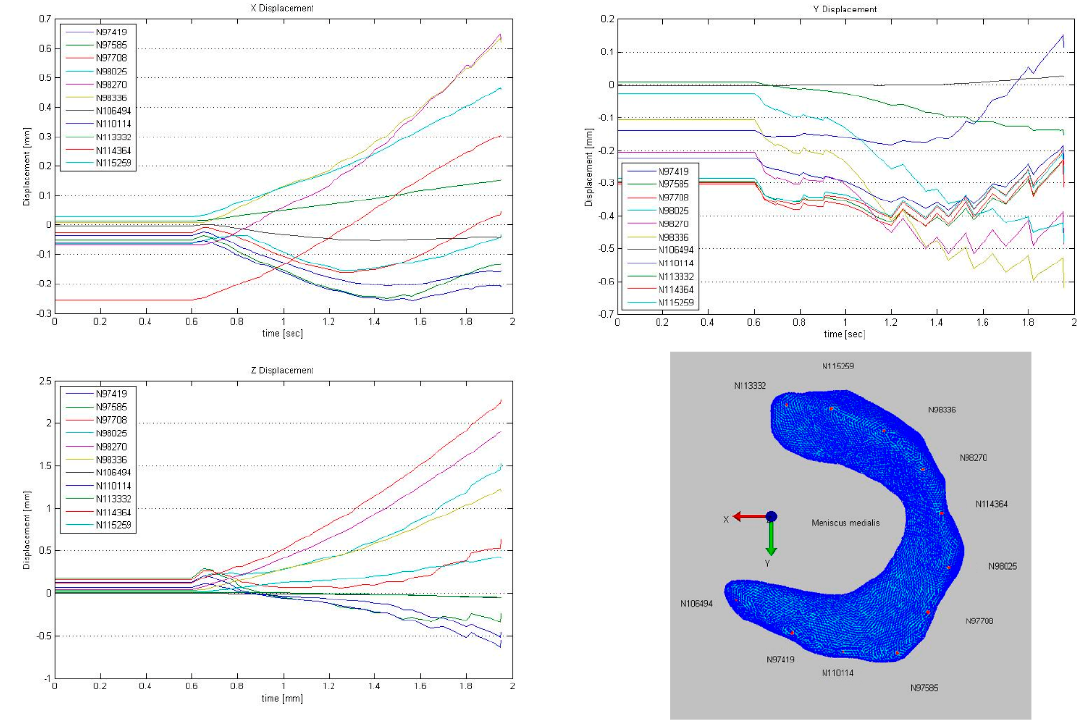
Figure 5. Displacement of ten virtually marked points at the peripheral contour of the medial meniscus during simulation.